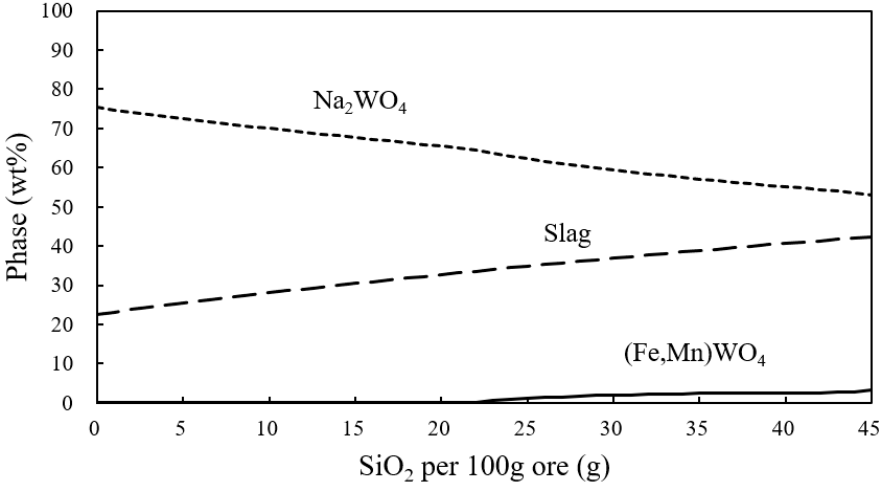
Figure 3. Effect of SiO 2 addition on phase fractions in air at 1200 °C with 30% Na 2 O, calculated by FactSage 8.2.